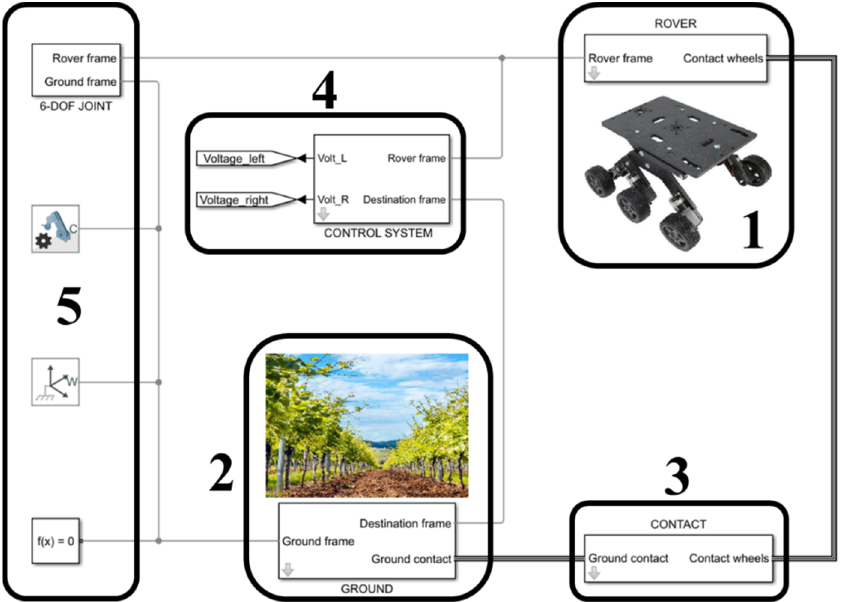
Figure 1. Main blocks composing the multibody simulation test rig for the agricultural rover design.